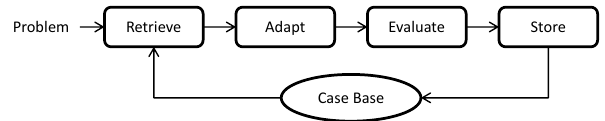
Fig. 1. The Case-based Reasoning